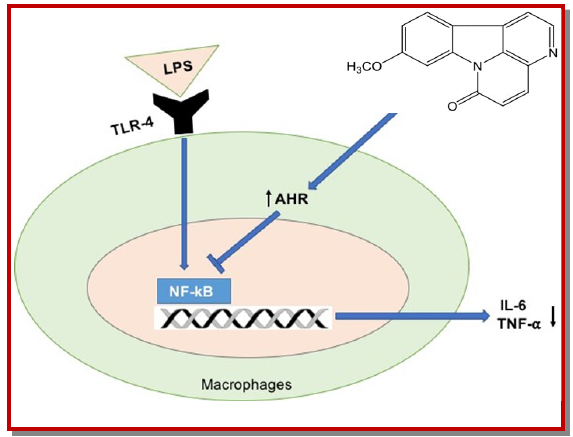
Figure 3: 9-Hydroxycanthin-6-one suppress inflammatory cytokines potentially via